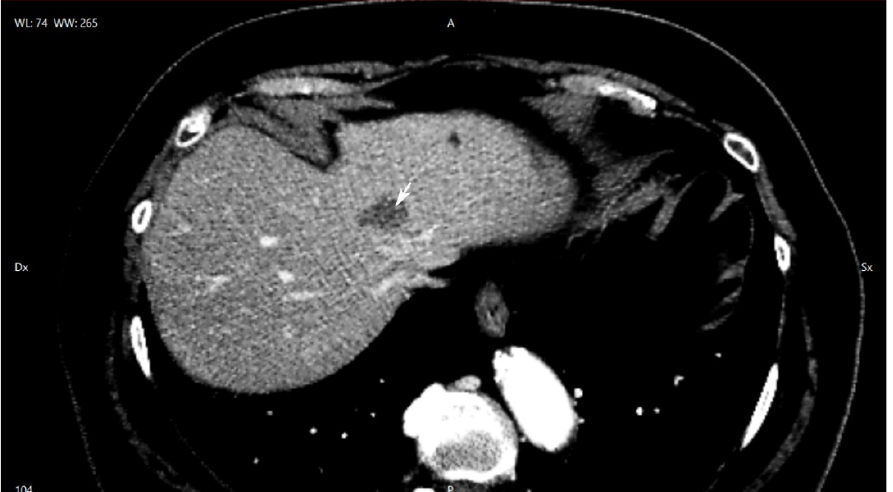
Figure 1. Upper portion of liver CT scan: lesion at the origin of the common hepatic trunk. (white arrow: lesion).